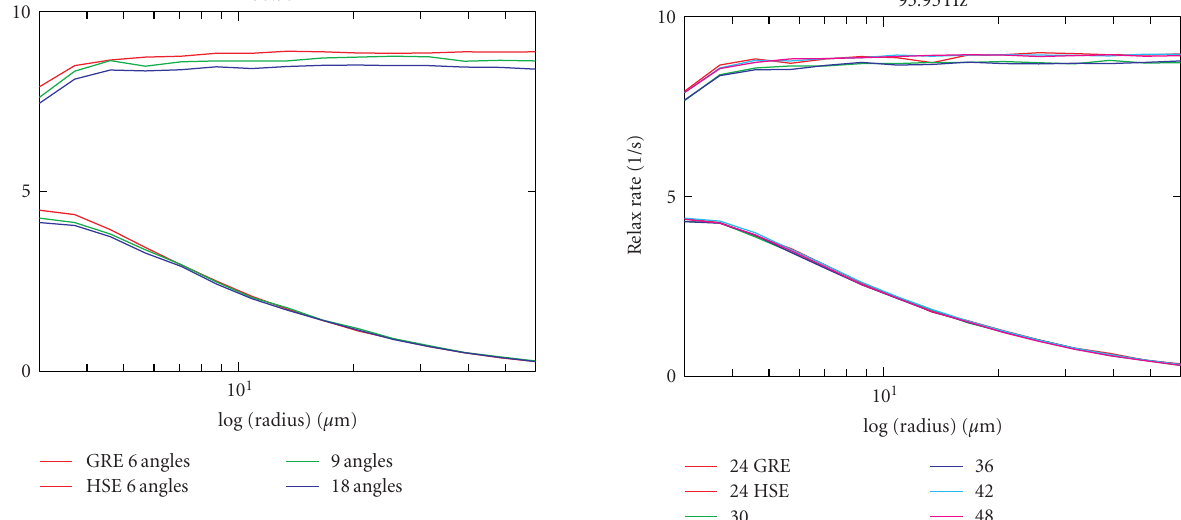
Figure 8: R2/R2 ∗ relaxation rates (in s − 1 ) shown for the computa- tional set up with edge lengths of the computational cell of 24, 30, 36, 42, and 48 mean spin-to-spin distances along each edge, corre- sponding to 24 3 , 30 3 , 36 3 , 42 3 , and 48 3 spins in each computational